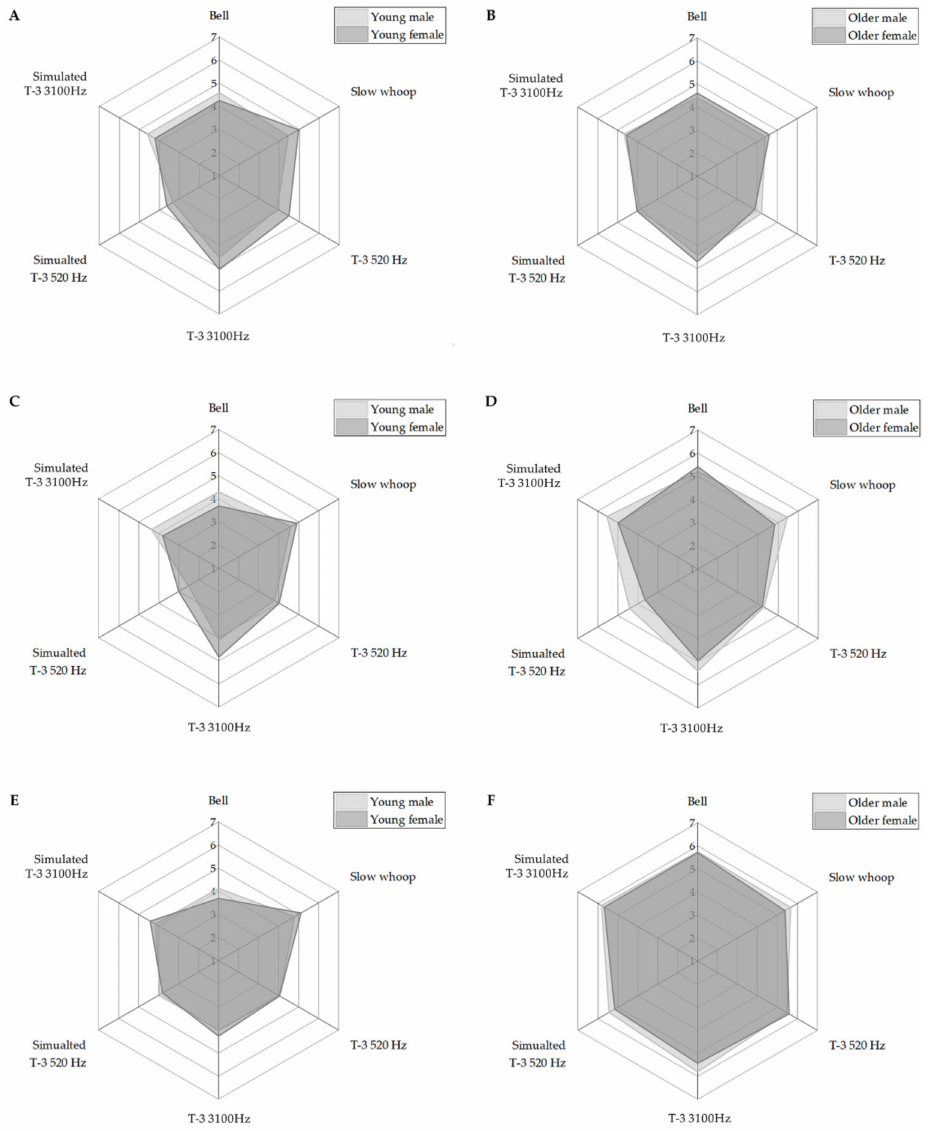
Figure 4. Results of psychoacoustic recognition induced by six different types of fire alarm sounds including age factor (left panels for young and right panels for old) and gender factors (light gray for male and dark gray for female): arousal ( A , B ), urgency ( C , D ), and immersion ( E , F